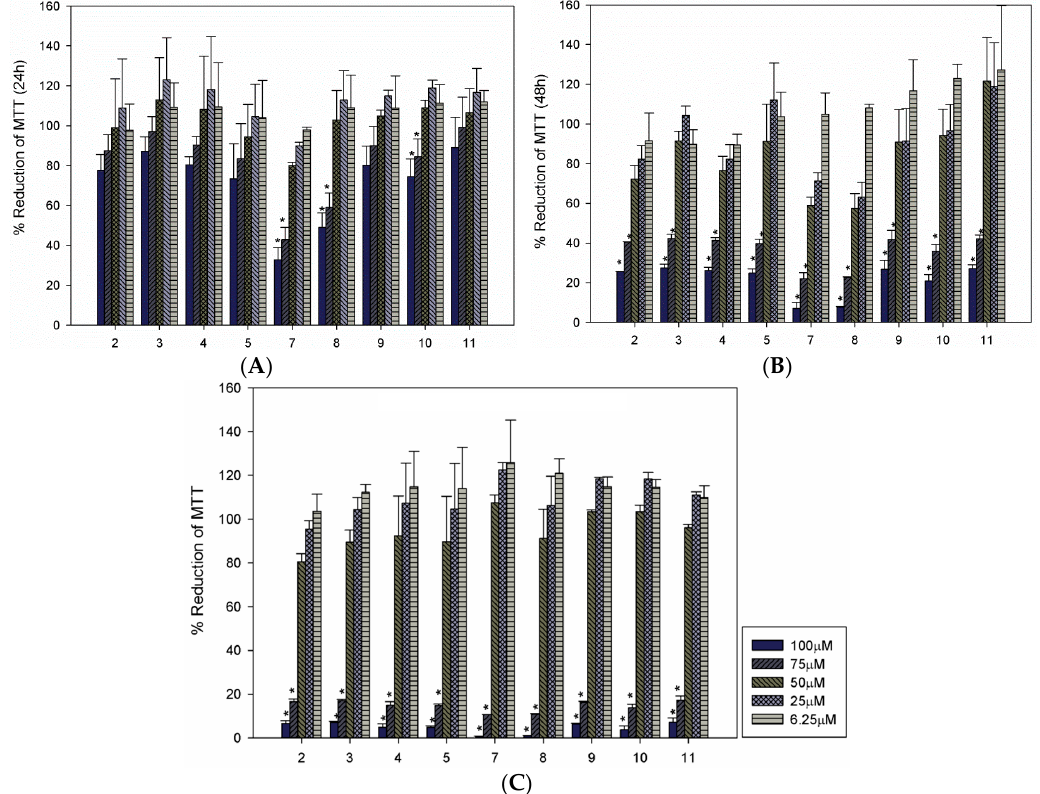
Figure 2. Leishmanicidal activities of isobenzofuranones 2 – 5 and 7 – 11 against promastigotes. MTT